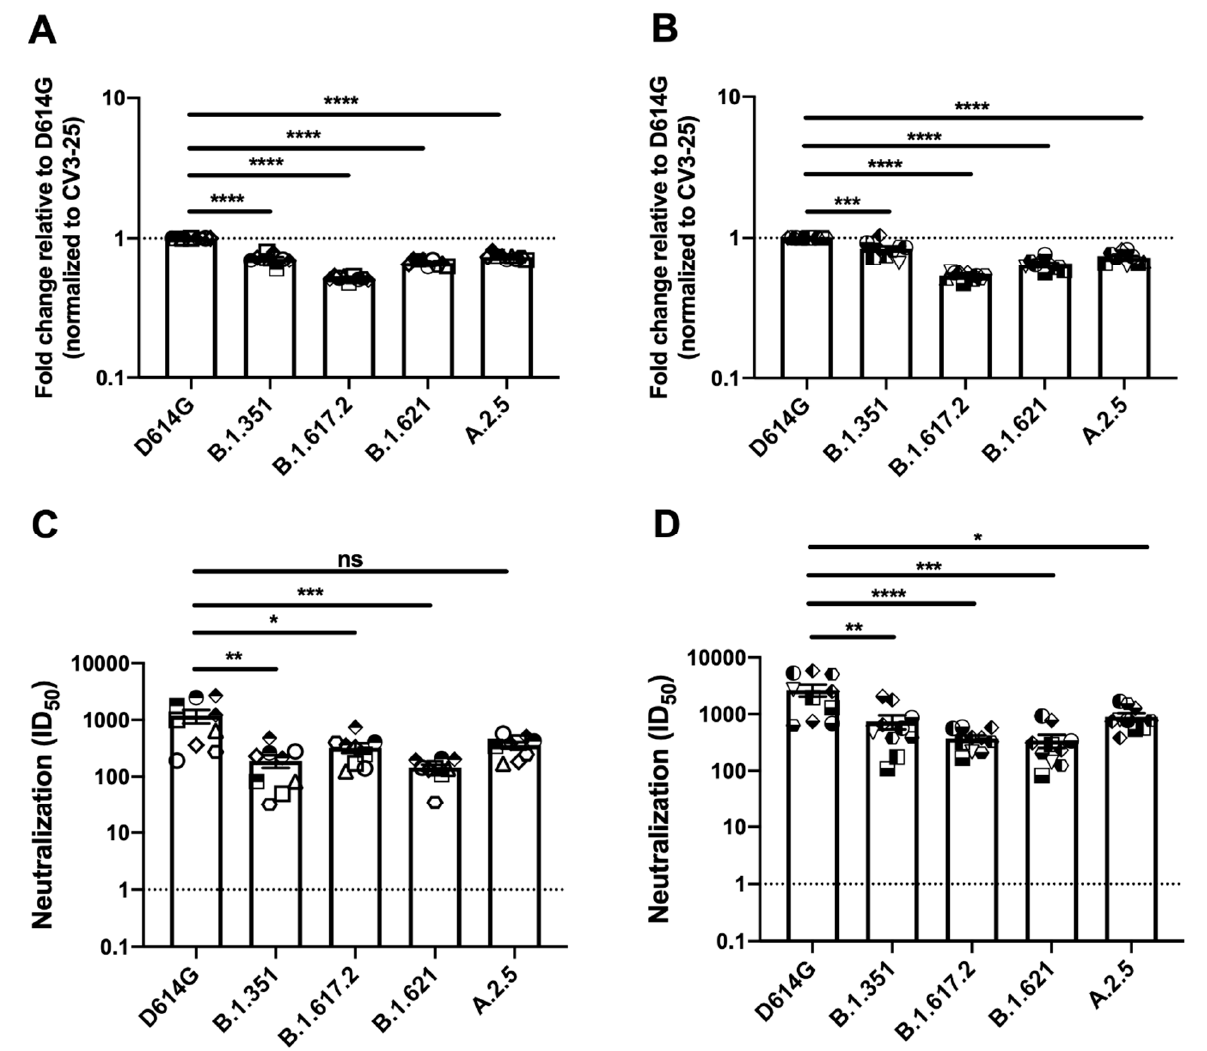
Figure 3. Evaluation of plasma recognition and neutralization ability of SARS-CoV-2 Spike variants of naïve or previously infected vaccinated individuals. HEK 293T cells were transfected with the indicated SARS-CoV-2 Spike variants. Two days post transfection, cells were stained with ACE2-Fc, 1:250 diluted plasma collected from naive vaccinated ( n = 9) or previously infected individuals ( n = 10) for each group or with CV3-25 Ab as control and analyzed by flow cytometry. Plasma recogni- tion of second dose vaccinated naïve individuals ( A ) and previously infected second dose vac- cinated individuals ( B ) are presented as ratio of plasma binding to D614G Spike normalized CV3- 25 binding. Neutralizing activity of same group of individuals against pseudoviruses bearing the SARS-CoV-2 Spike variants were assessed. Pseudoviruses with serial dilutions of plasma were in- cubated for 1 h at 37 °C before infecting 293T-ACE2 cells. ID 50 against pseudoviruses were calculated by a normalized non-linear regression using GraphPad Prism software. Neutralization activity of second dose vaccinated naïve individuals ( C ), and previously infected second dose vaccinated in- dividuals ( D ) are represented. Limits of detection were indicated with a dotted line in the graph (ID 50 = 30). Error bars indicate means ± SEM. Statistical significance was performed using Mann– Whitney U test (* p < 0.05; ** p < 0.01; *** p < 0.001; **** p < 0.0001, ns, non-significant). 4. Discussion In this study, we analyzed the Spike glycoproteins of emerging variants Mu and A.2.5 and compared them to the Beta and Delta Spike variants. In line with previous reports, Beta and Delta Spikes showed a significant increase in ACE2-Fc binding [24,34–36], Mu and A.2.5 also bound ACE2 better than D614G but to a lower extent than Beta and Delta Spikes. Whether this differential ACE2 interaction influences the transmission rate of these variants remains unclear.